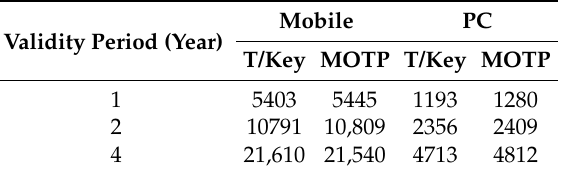
Table 4. Initialization time cost of T/Key and MOTP